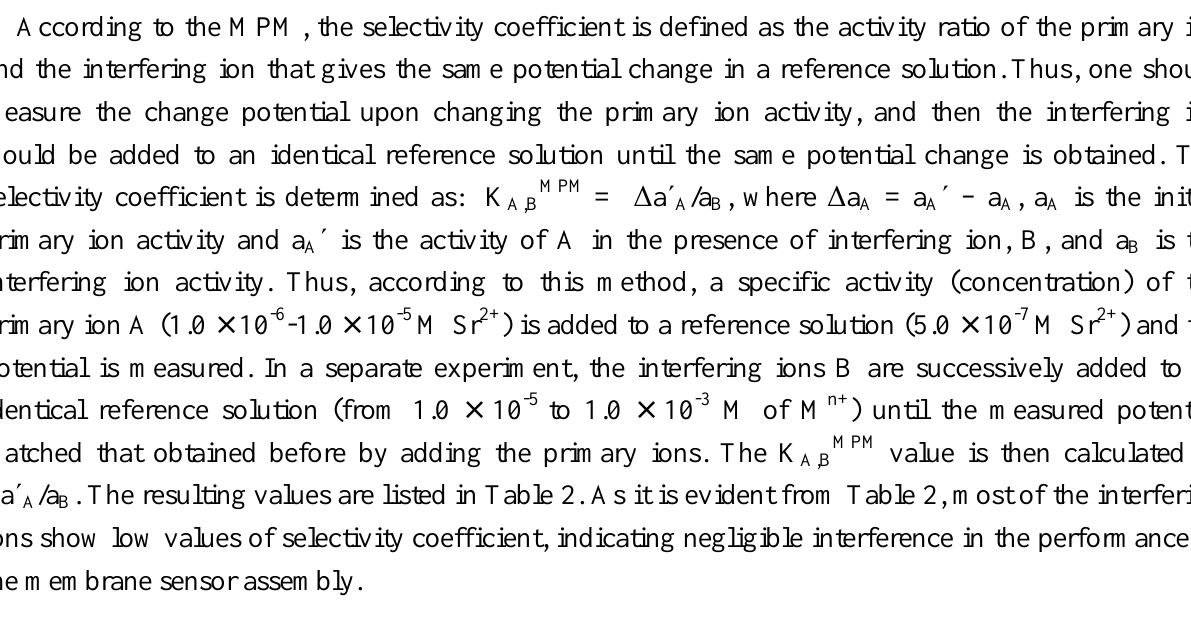
Table 2. Selectivity coefficients of various interfering